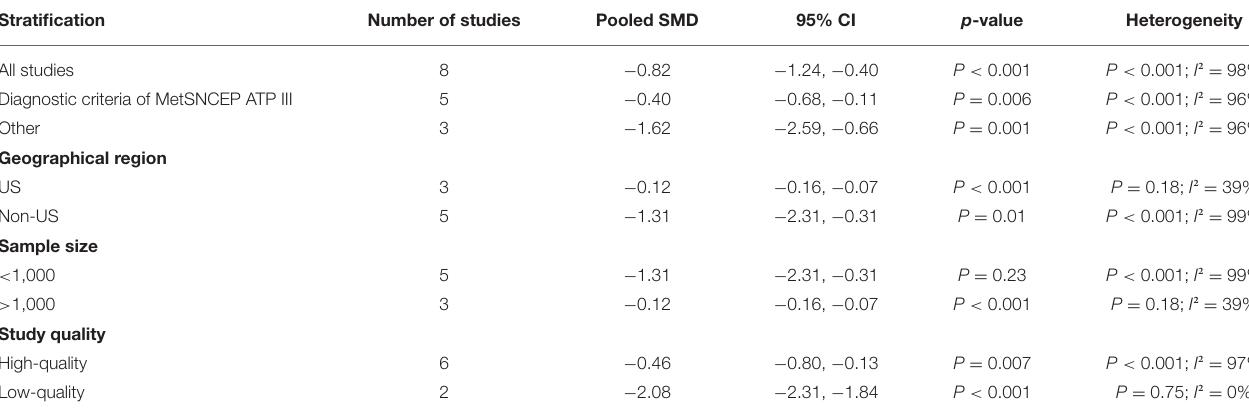
TABLE 4 | Subgroup analysis for SMD of circulating vitamin C level in MetS vs. control